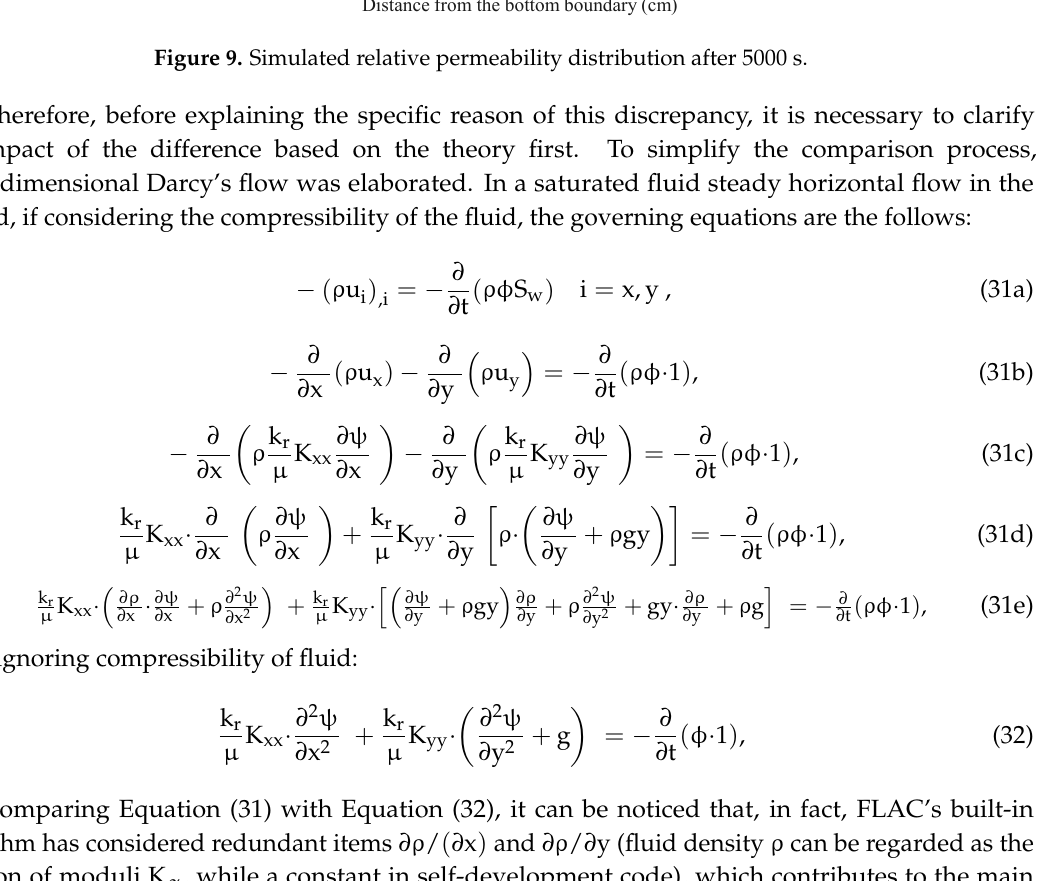
13 of 20 Figure 7. Simulated water-phase saturation distribution after 5000 s.